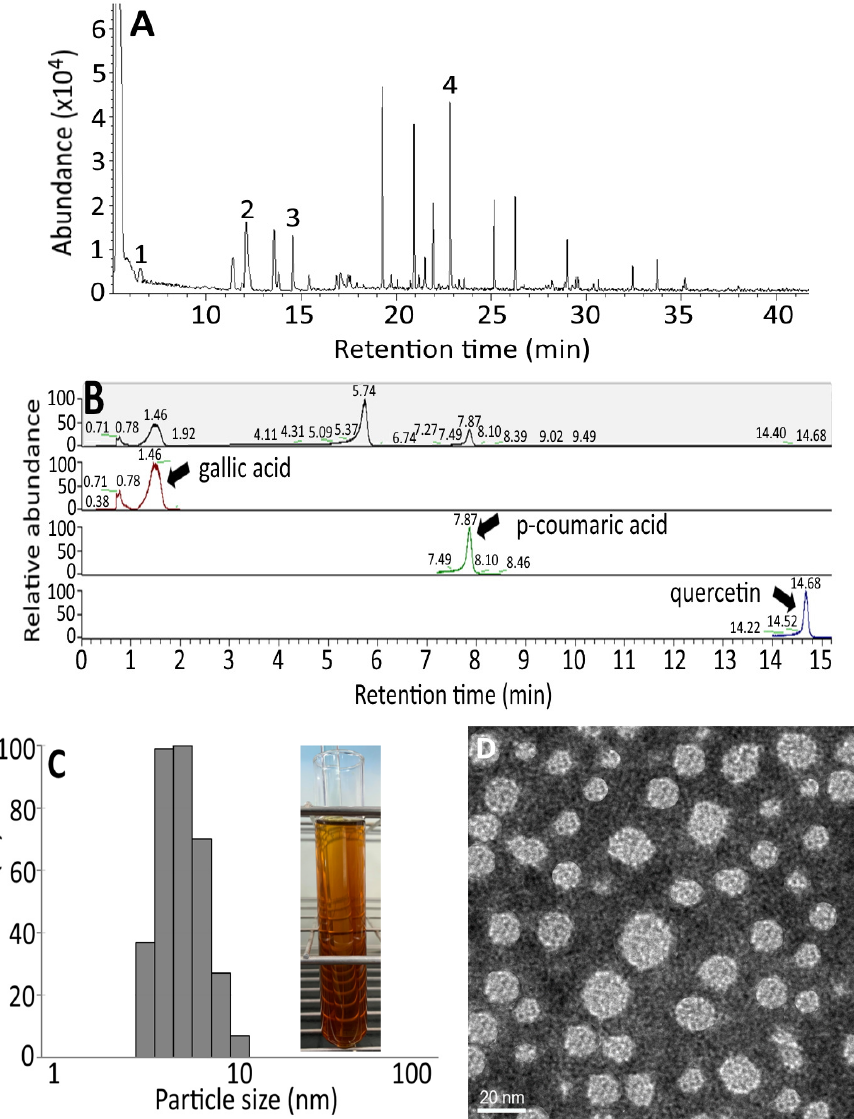
Figure 1. GC-MS chromatogram of black garlic extract using a DB-5MS column ( A ) and UPLC-MS/MS chromatograms of phenolic acid and flavonoids in black garlic with total ion chromatogram shown on the top and the other three being SRM chromatograms ( B ) as well as the particle size distribution of black garlic nanoemulsion by a dynamic light scattering method along with an inset showing its appearance ( C ) and transmission electron microscopic image ( D ). Peaks: 1, diallyl sulfide (DAS); 2, isopropyl disulfide (internal standard); 3, diallyl disulfide (DADS); 4, diallyl trisulfide (DATS). Table 1. ( A ) Contents ( μ g/g) of organosulfur compounds in raw and black garlic by GC-MS analysis. ( B ) Effect of different ethanol proportion on the contents of total phenolic acids and total flavonoids in raw and black garlic by UPLC-MS/MS analysis.